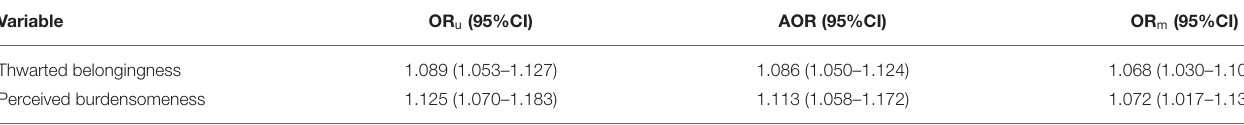
TABLE 2 | Logistic regression model of the suicidal ideation based on the interpersonal theory of suicide.